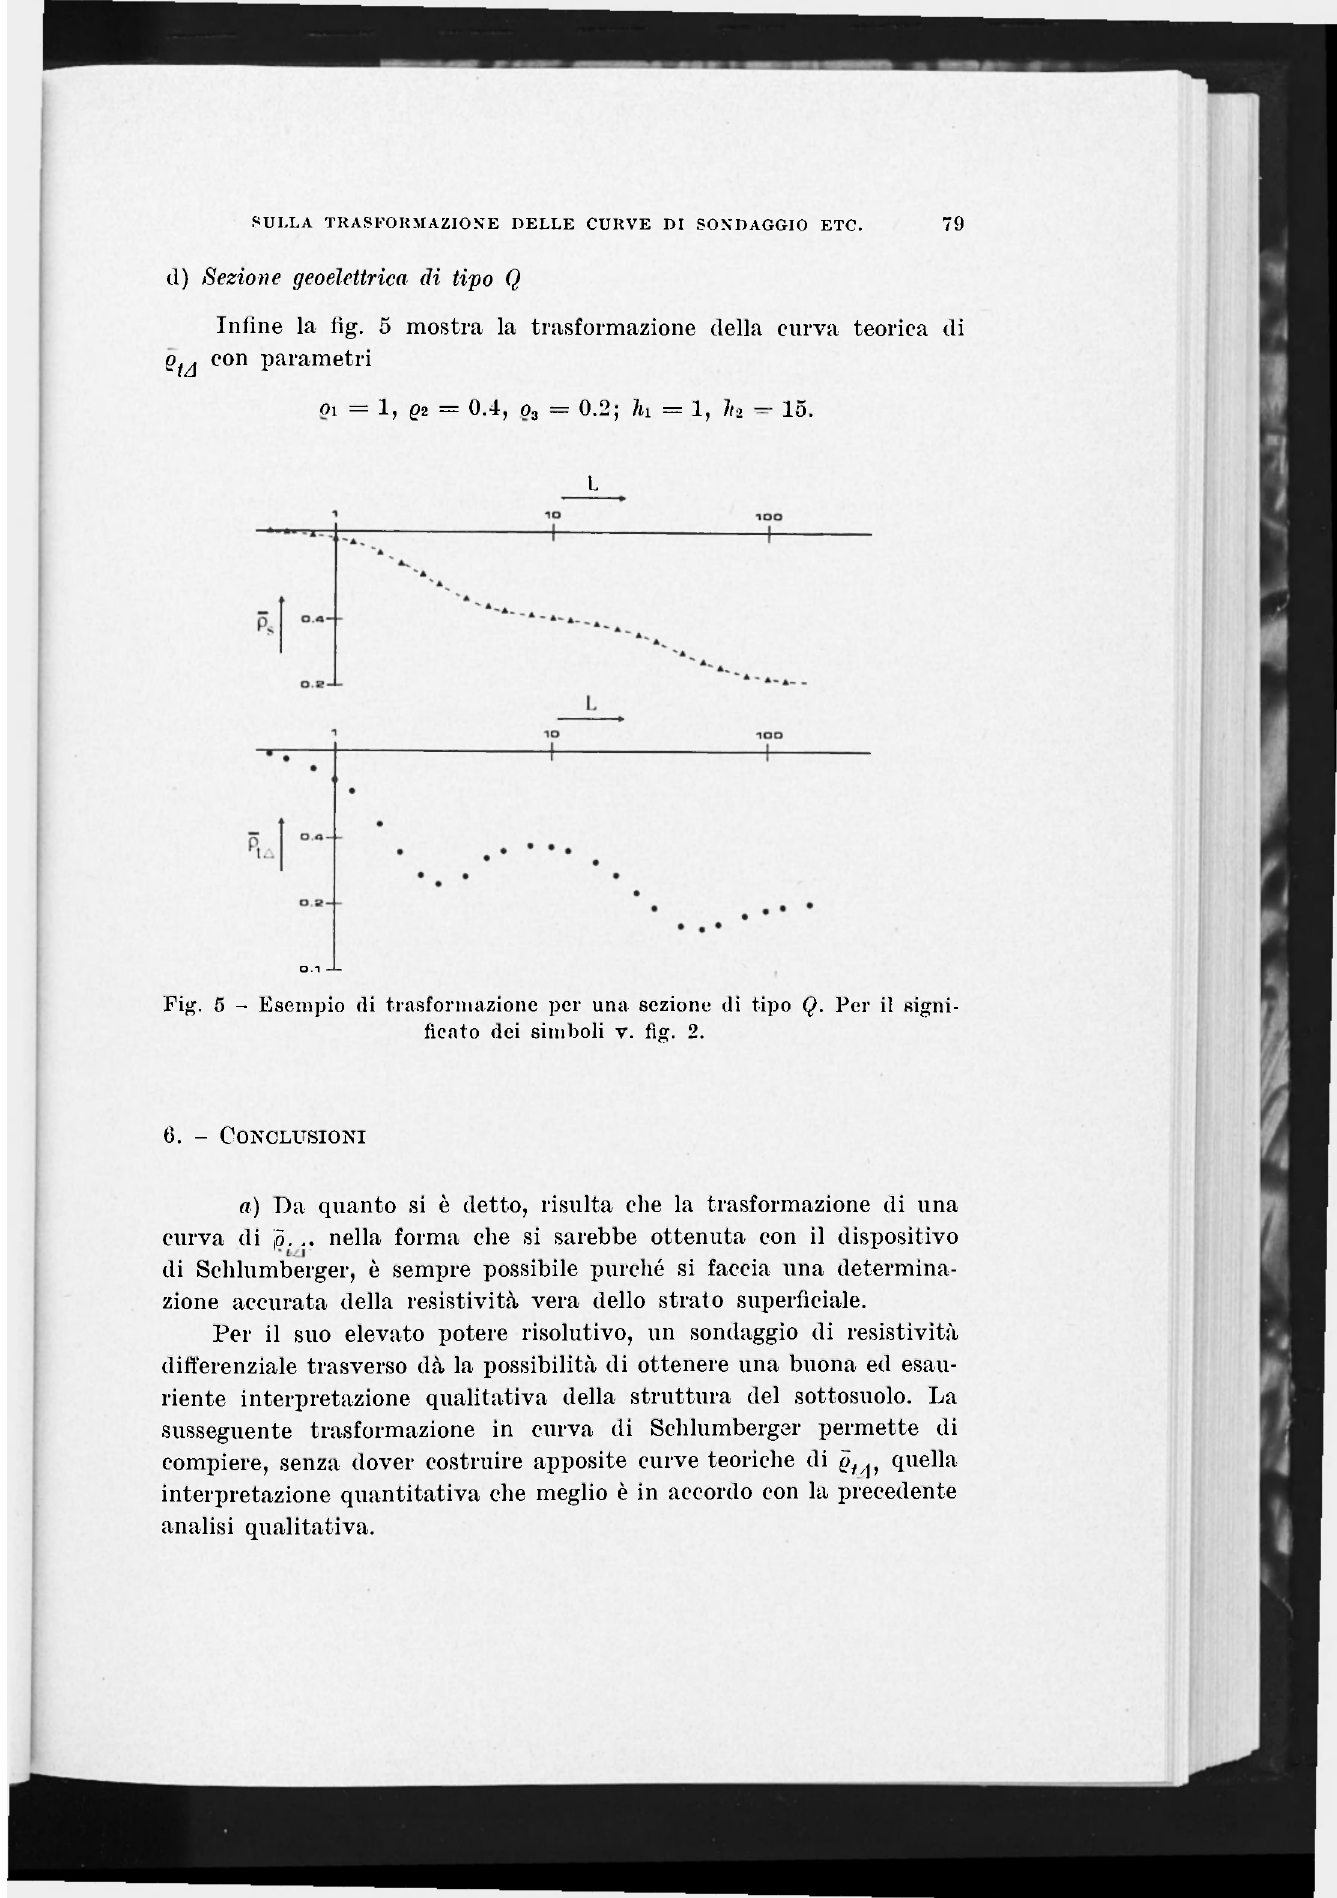
Fig. 5 - Esempio di trasformazione per una sezione di tipo Q. Per il signi- ficato dei simboli v. fìg.